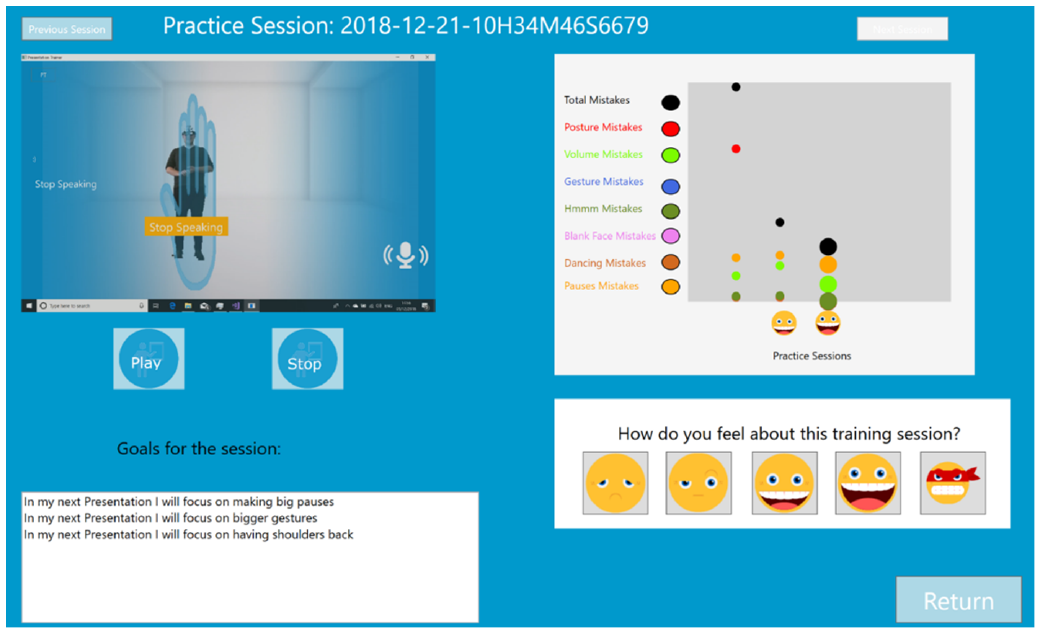
Figure 2. Post-practice Histogram. Top Left Video of the Practice Session. Top Right progress evolution according to percentage of time spent on mistakes. Bottom Left goals for the practice session. Bottom Right: self-evaluation.